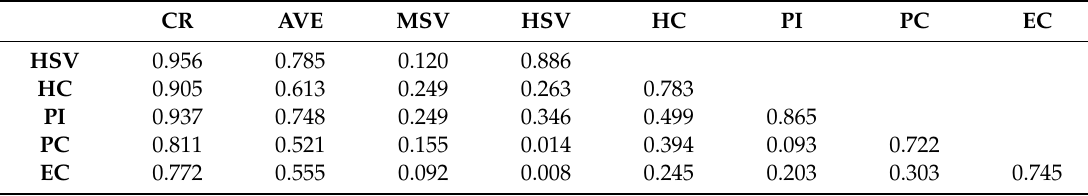
Table 3. Overview of reliability and validity